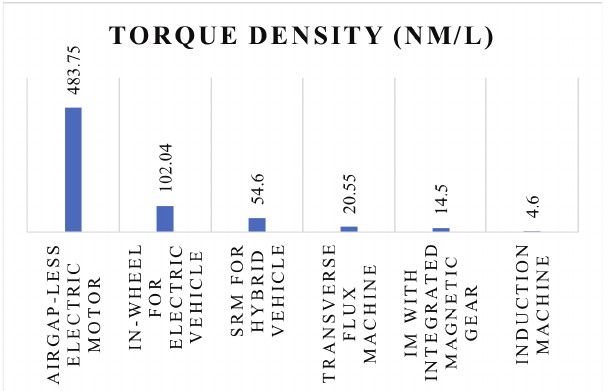
Figure 13. Torque Density Comparison Chart for Electric Motors without Permanent Magnet.